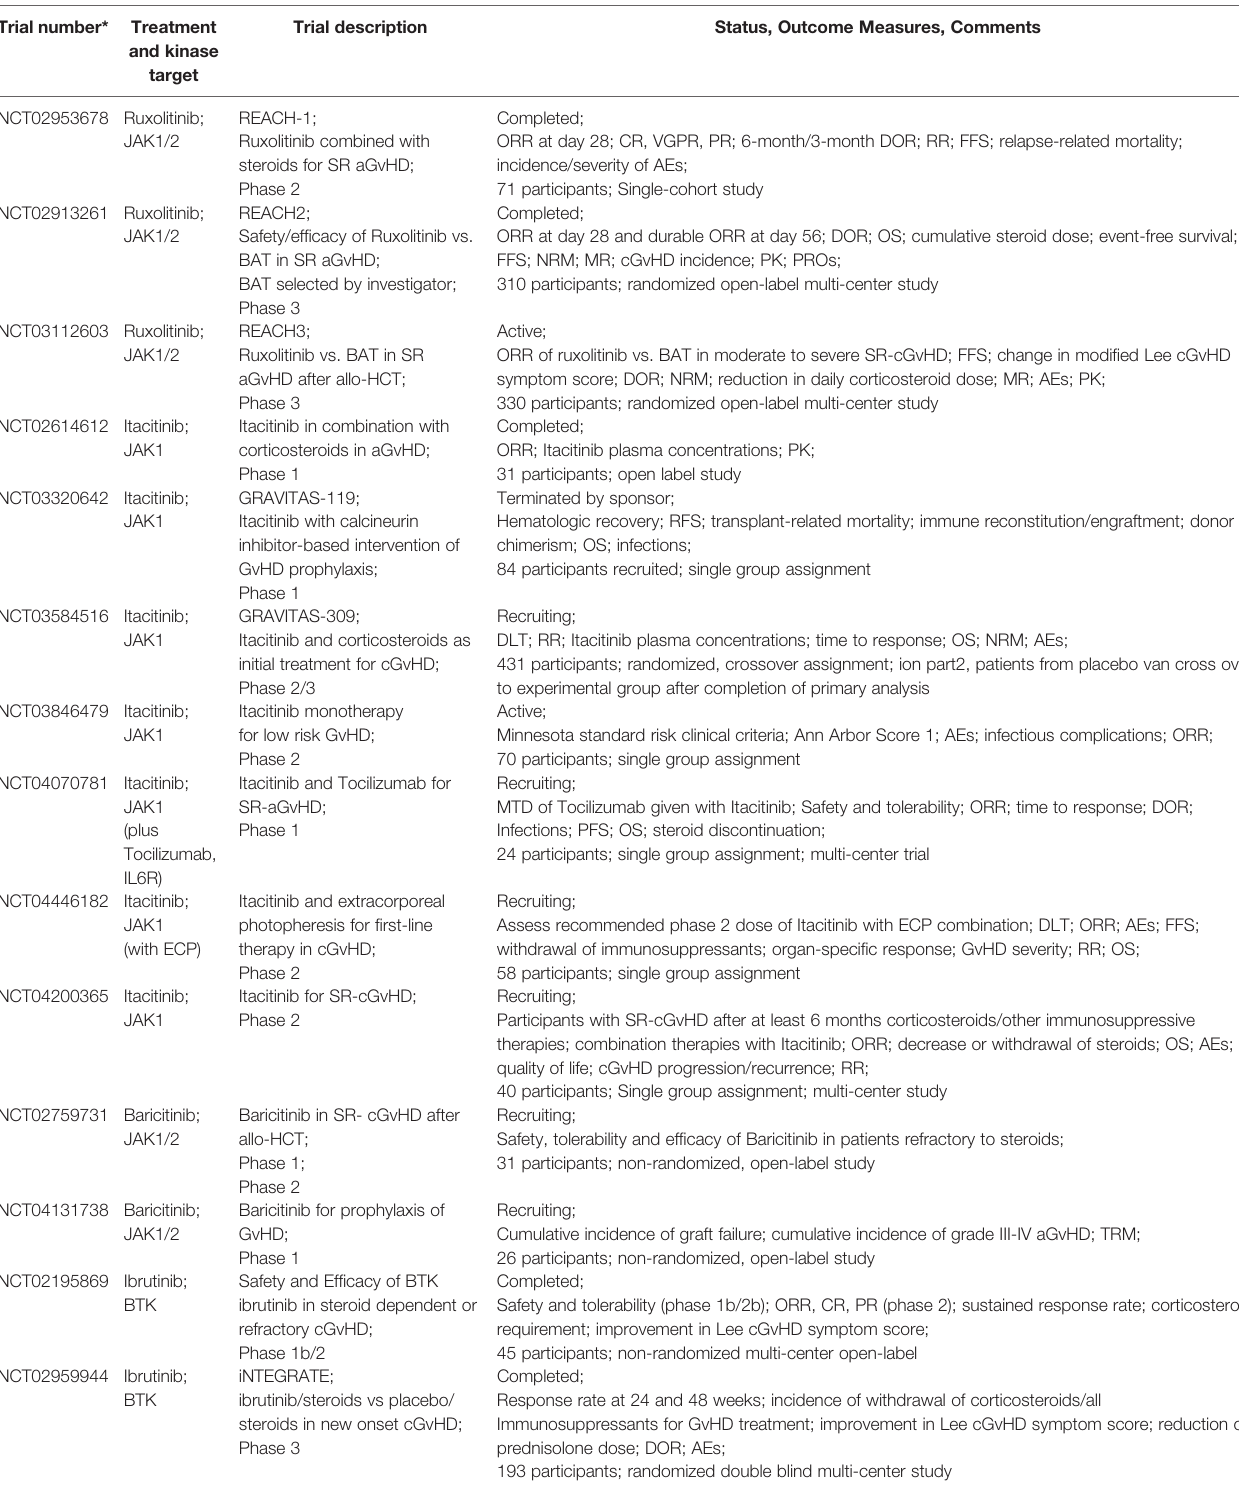
TABLE 1 | Selected clinical trials of kinase inhibition in GvHD. Trial number* Treatment and